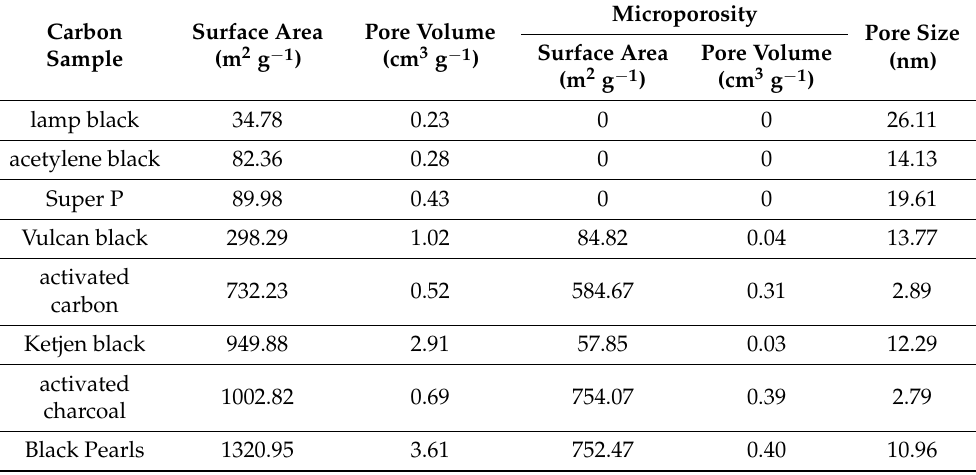
Figure 2. Material characteristics: scanning electron microscopy of ( a ) lamp black, ( b ) acetylene black, ( c ) Super P, ( d ) Vulcan black, ( e ) activated carbon, ( f ) Ketjen black, ( g ) activated charcoal, and ( h ) Black Pearls for the carbon-coated separators.